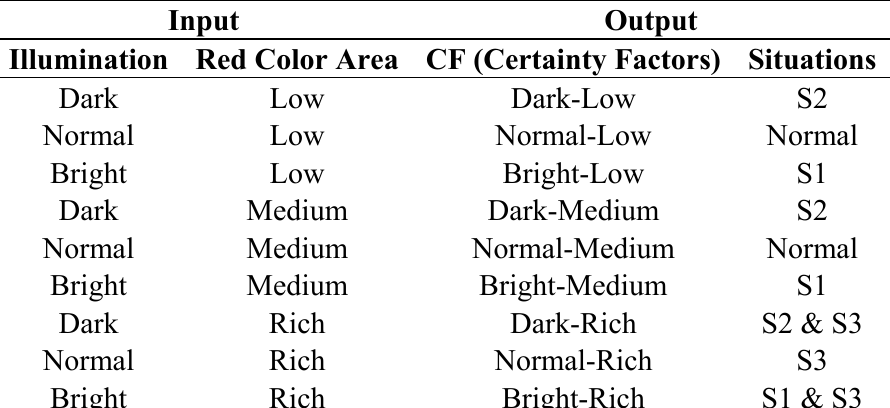
Table 1. Fuzzy rules for determining image